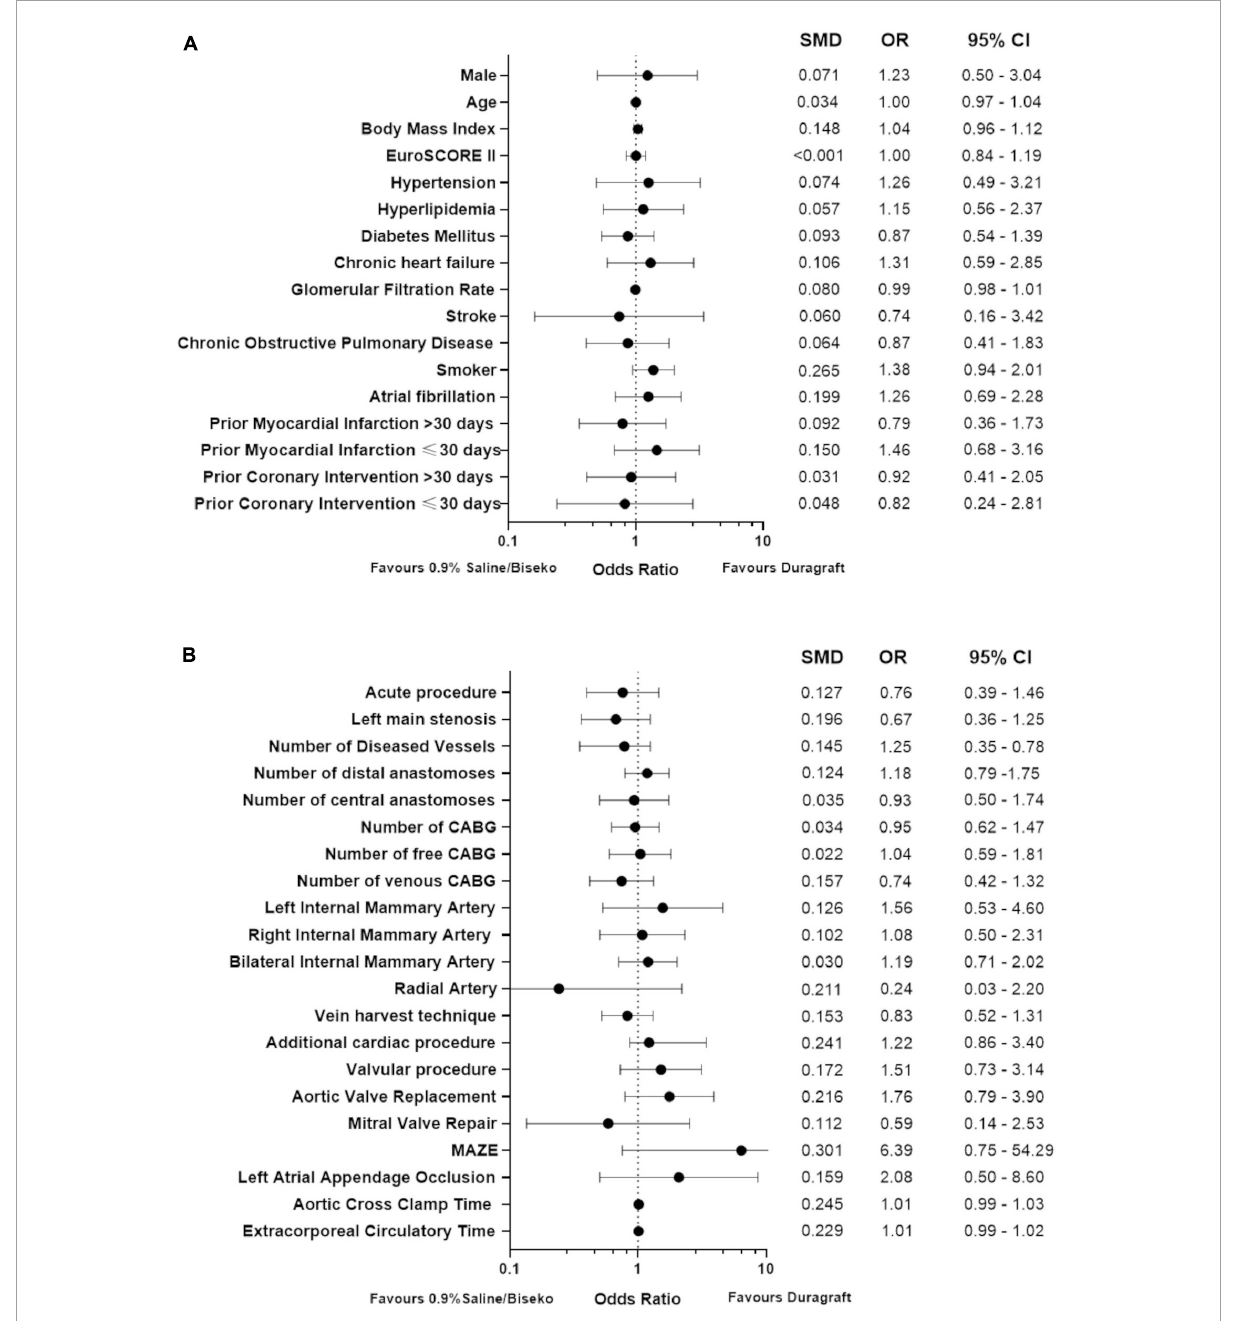
FIGURE2 Forest plot presenting diagnostic odds ratios and effect size of baseline (A) and procedural variables (B) after propensity score matching; CABG, coronary artery bypass grafting; SMD, standardized mean differences, OR, odds ratio, 95% CI, 95% confidence interval.